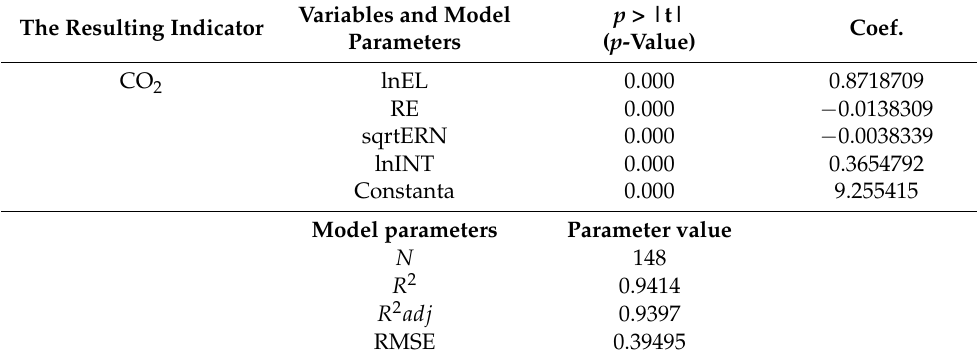
Table 4. Final regression model.